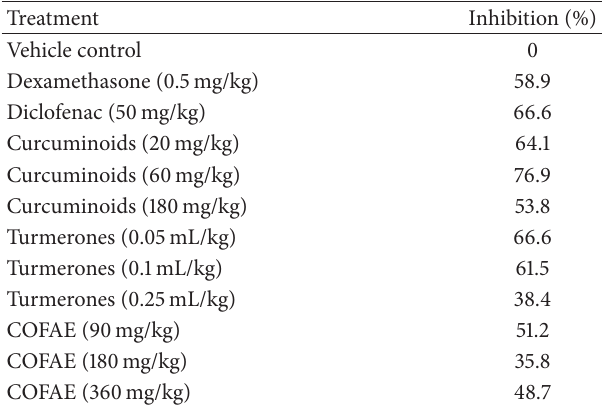
Table 1: Percentage inhibition of xylene-induced ear edema by curcuminoids, turmerones, and